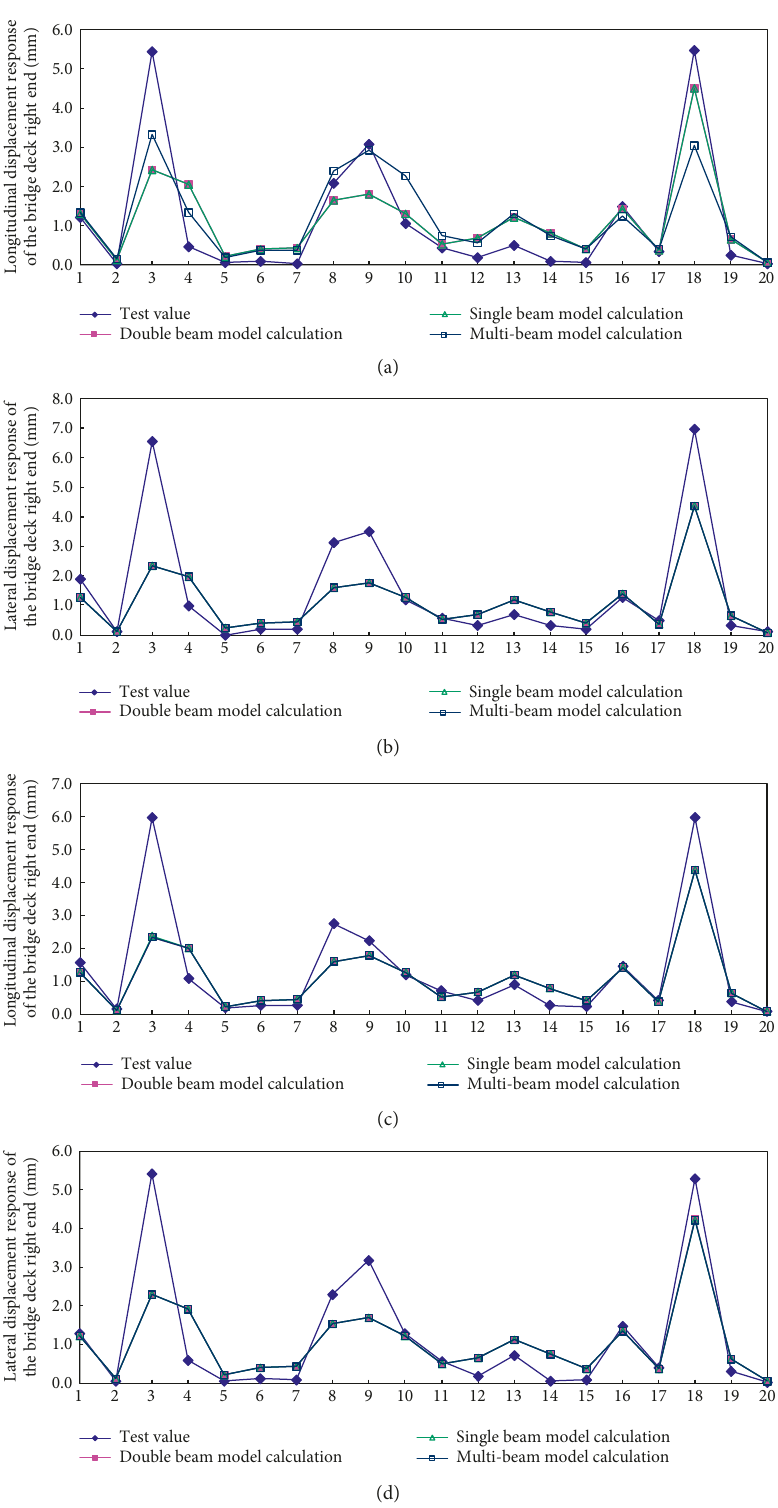
Figure 6: Displacement responses of the right end of the bridge deck. (a) Longitudinal response under longitudinal seismic waves. (b) Lateral response under transverse seismic wave. (c) Longitudinal response under the action of two-way seismic wave. (d) Lateral response under the action of two-way seismic